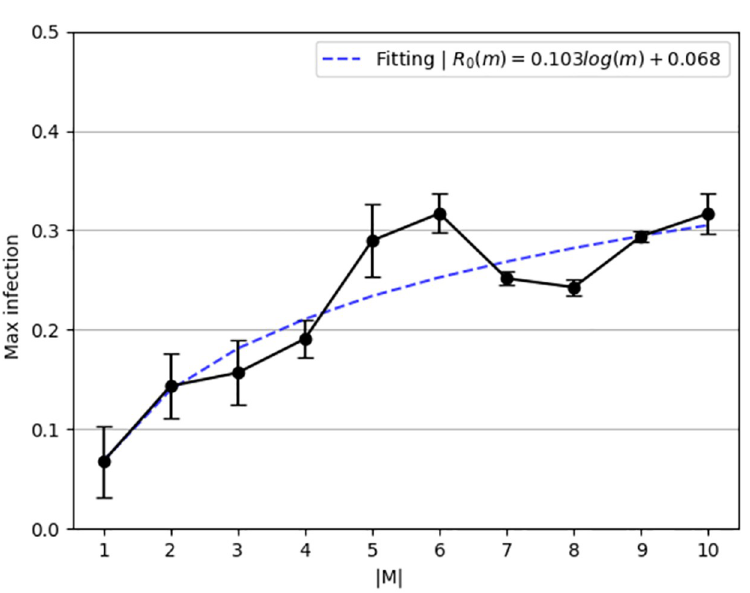
Fig 3. Maximum number of infectious individuals at the same time as a function of the number of strains (|M|). The results are mean ± standard division for n = 1000 repetitions.